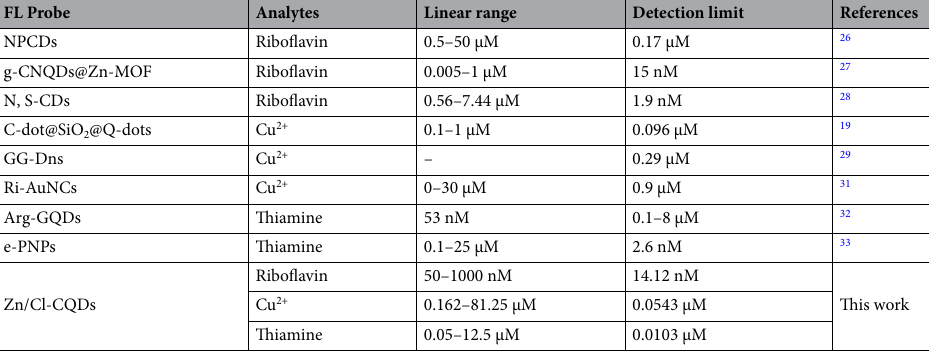
Table 1. Comparison of different fluorescence-based probes for the detection of riboflavin, Cu 2+ and